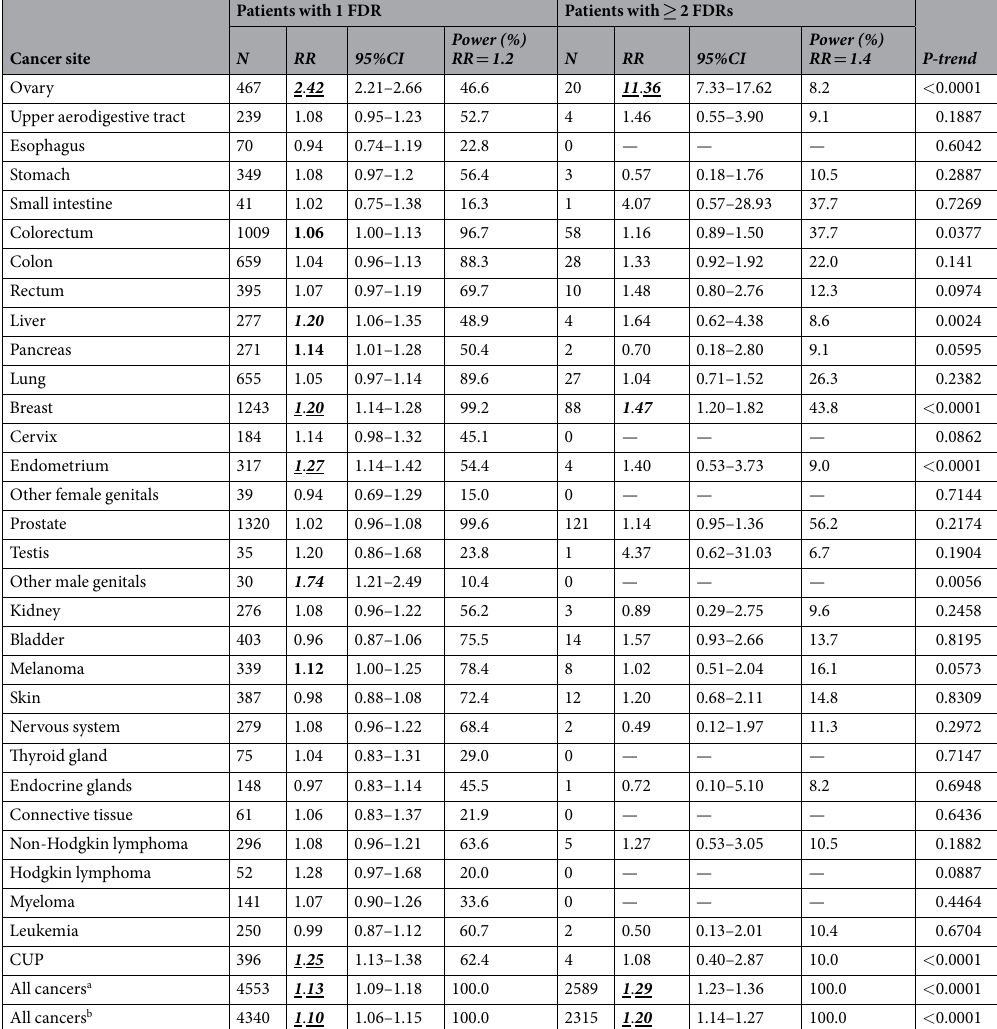
Table 2. Invasive ovarian cancer risk when first-degree relatives were diagnosed with other cancers. FDR: first- degree relative; CUP: cancer of unknown primary. Bolding, italic and underlining indicate that the 95% CI, 99% CI and 99.9% CI did not overlap with 1.00 respectively. a all cancers include ovarian cancers and all other cancers. b all cancers include all other cancers except ovarian